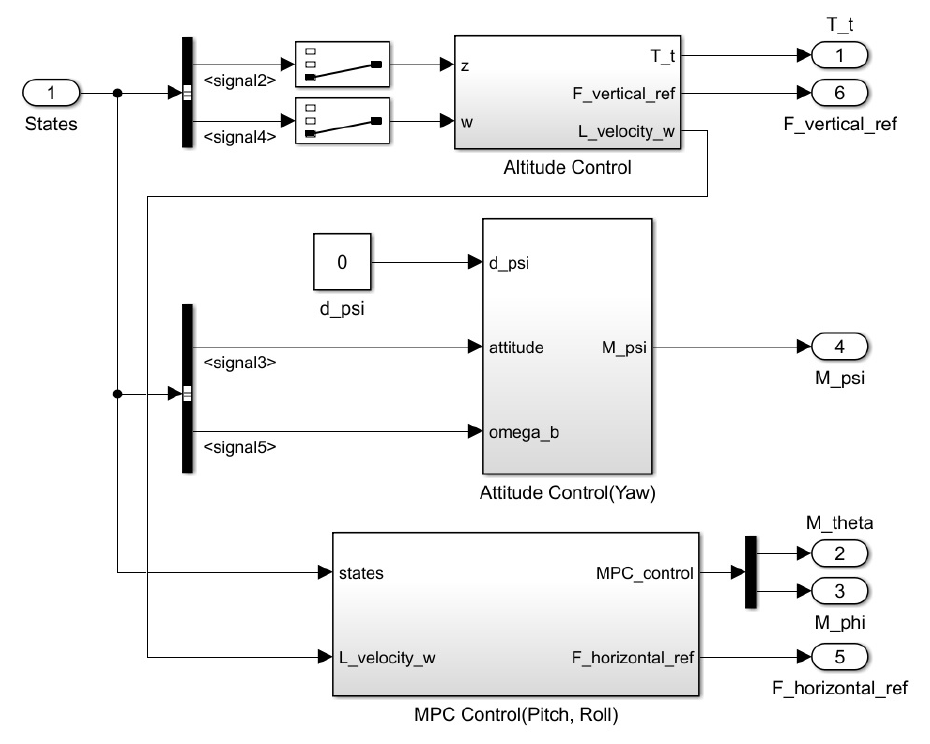
Figure 8. Configuration of the control